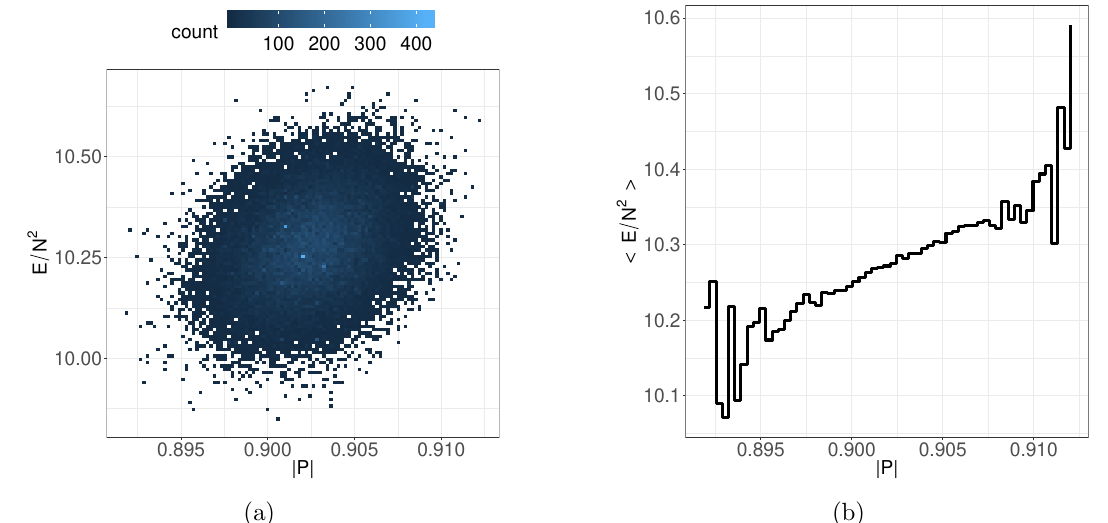
Figure 18. a) Distribution of E and j P j at N = 64 ; L = 24 ; D = 10 ; T = 1 : 5. b) h E i ( j P j ) for the same data set.